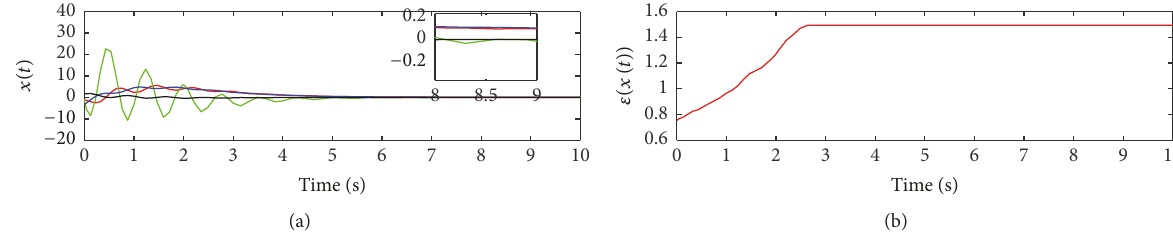
Figure 1: The state trajectories of one-link manipulator and the evolution of the scheduled parameter 𝜀(𝑥(𝑡)) .